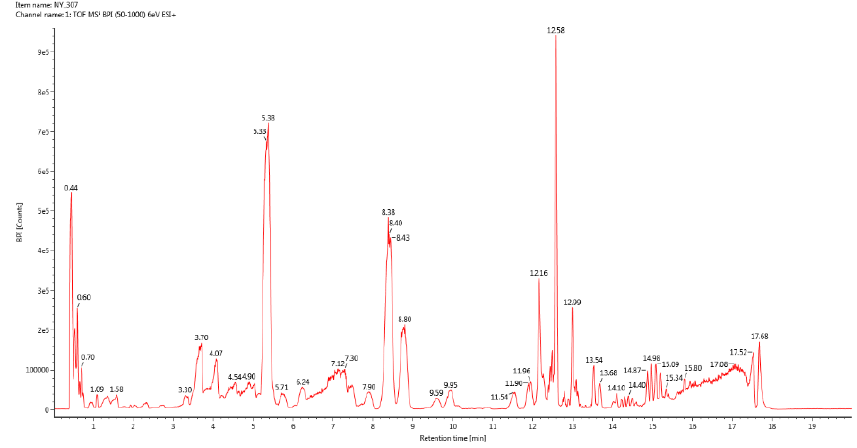
Figure 3. BPI total ion chromatogram of group 3.